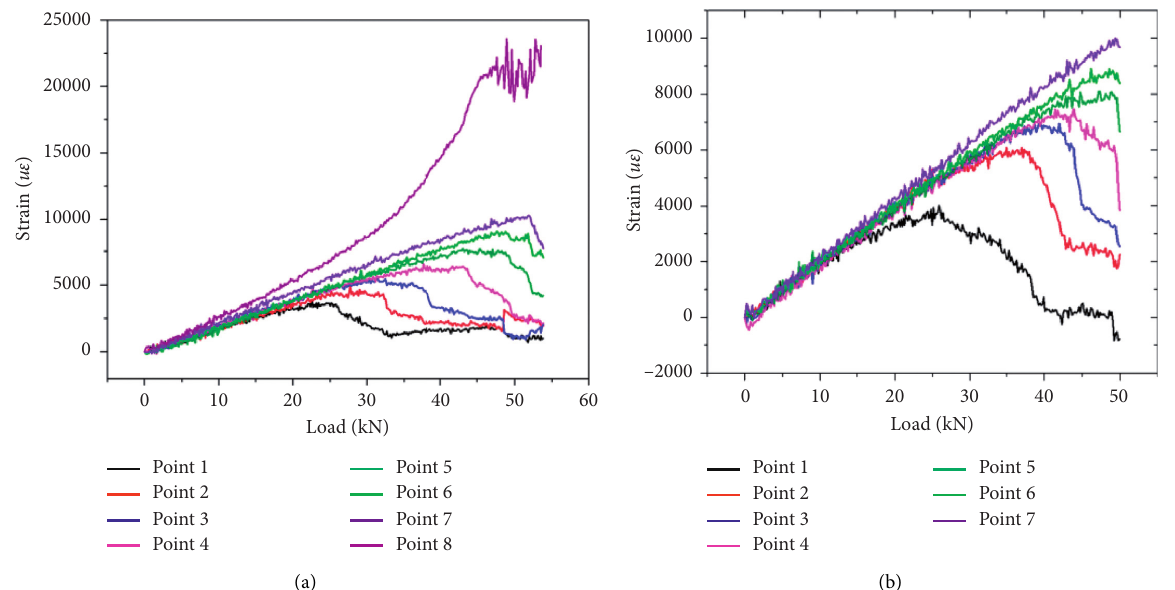
Figure 4: Strain-load curves of specimen with (a) L � 15mm and (b) L �